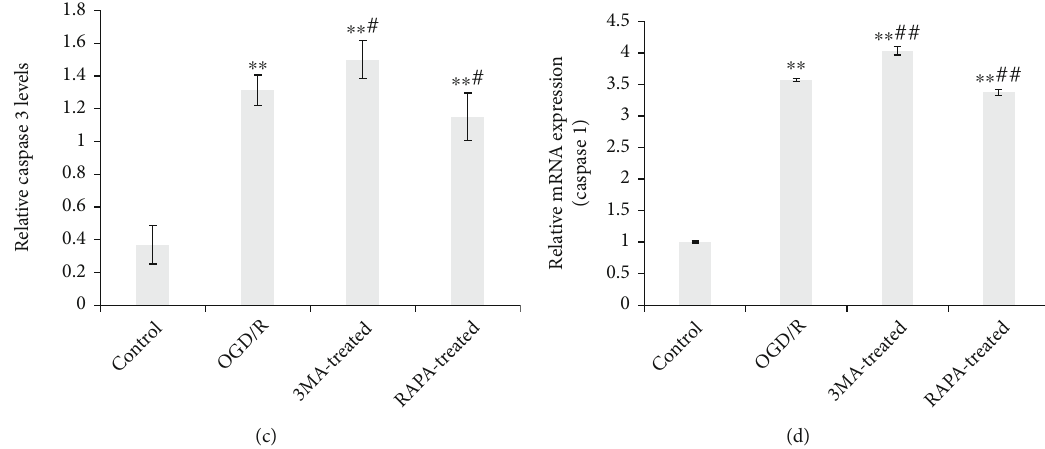
Figure 2: Oxidative stress-induced apoptosis accompanied with autophagy in microglia. Apoptosis was assayed in microglia and OGD/R-induced microglia, and the autophagy inhibitor 3MA and autophagy agonist RAPA were involved. Apoptosis was measured using both TUNEL staining ( × 800) (a) and JC-1 assay by fl ow cytometry (b). The apoptosis-related protein of caspase 3 was also detected using the ELISA kit (c). The mRNA expression of caspase 1 was detected using qPCR (d). The data was given as mean ± SD , n = 3 . ∗∗ p < 0 : 01 compared with microglia in culture (control). # p < 0 : 05 and ## p < 0 : 01 compared with microglia on glucose depreciation/reoxygenation (OGD/R) culture condition